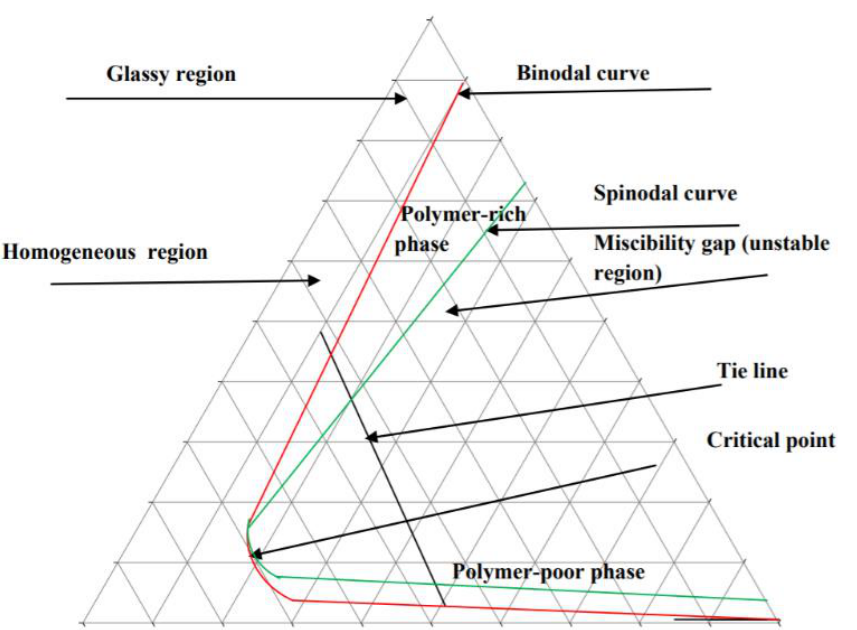
Figure 9. Ternary phase diagram of polymer-solvent-non-solvent mixture. Reprinted from [113], Copyright 2012 Australian Journal of Basic and Applied Sciences (AJBAS).